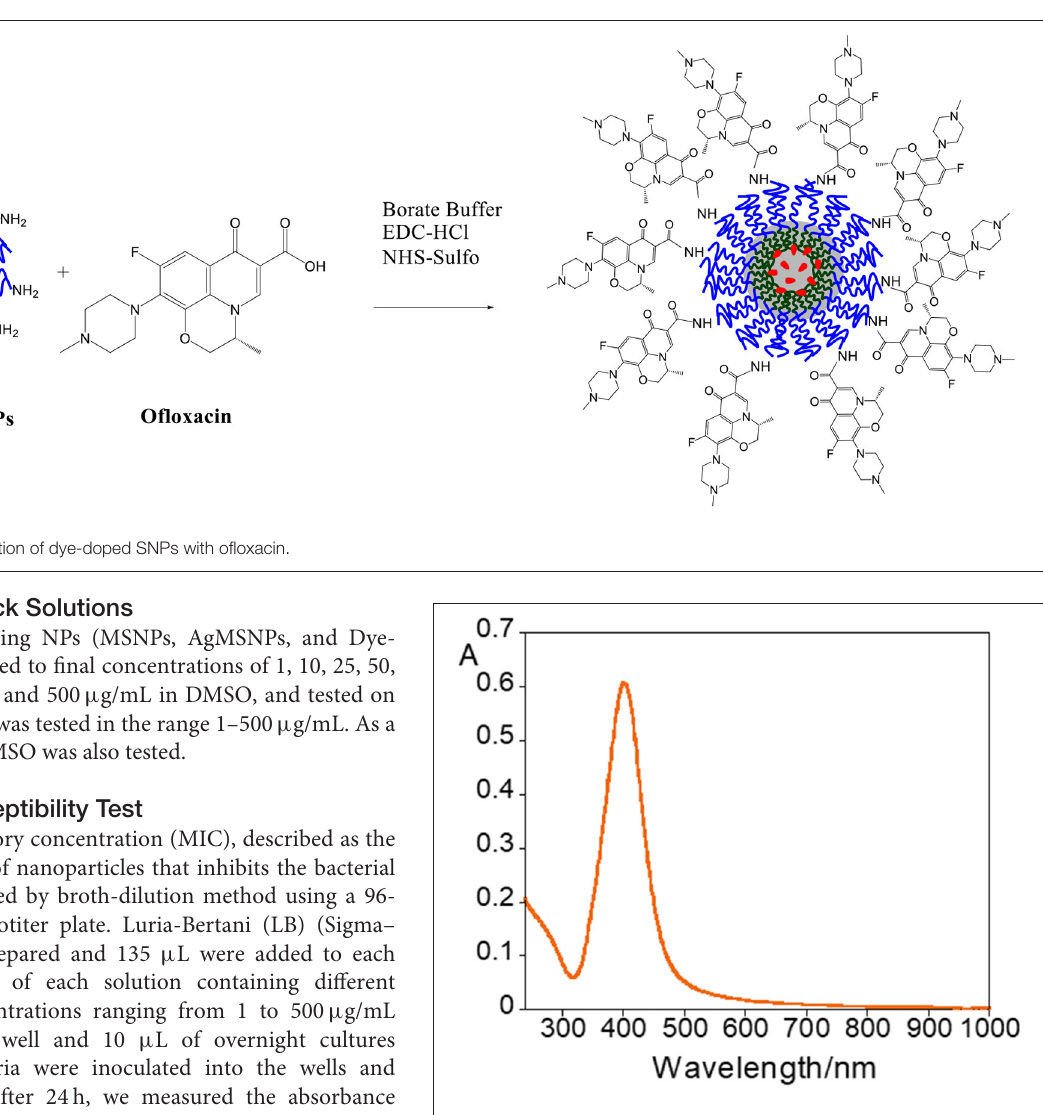
FIGURE 1 | Absorption spectra of